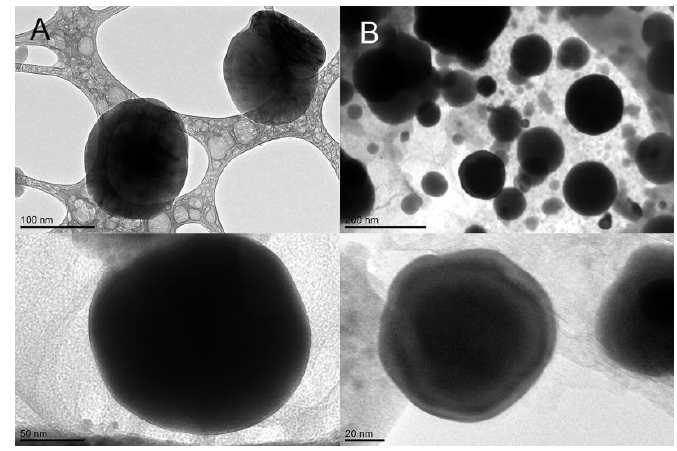
Figure 2. Cryo-transmission electron microscopy (cryo-TEM) images of blank ( A ) and Rp-SLN ( B ). Magnification 180,000× and 200,000×.